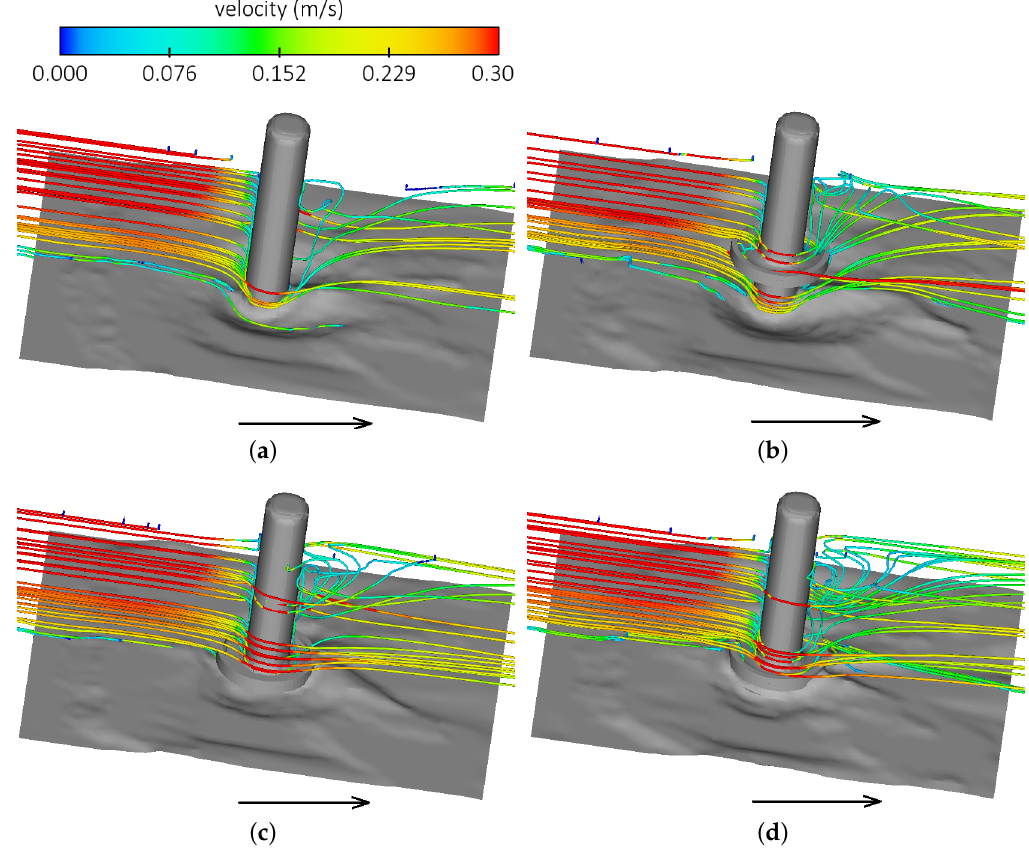
Figure 7. Visualization of streamlines: ( a ) no hooked-collar; ( b ) single hooked-collar at 0.25 b ; ( c ) single hooked-collar at bed level; and ( d ) double collar at the bed and buried − 0.25 b